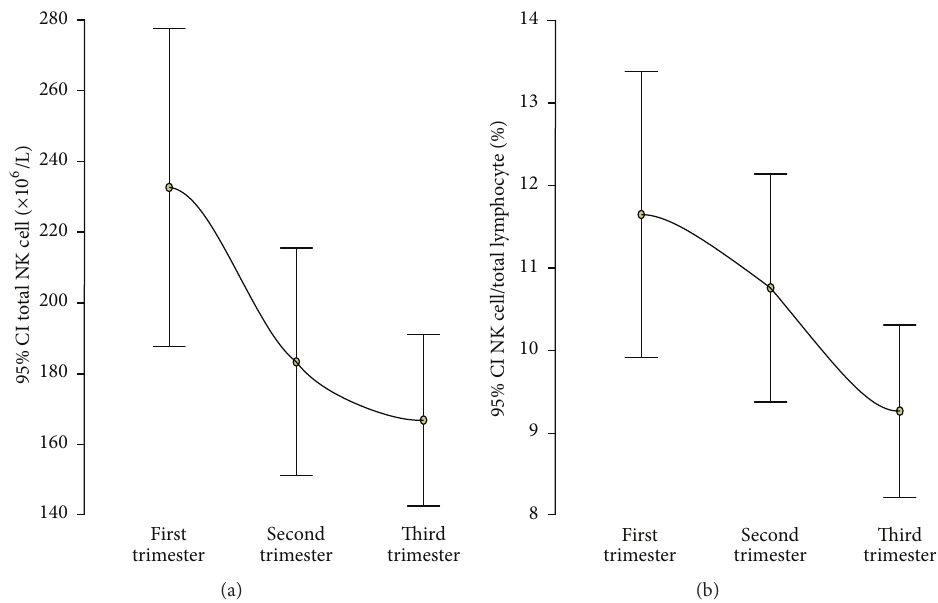
Figure 3: Error bar plots of the mean and 95% confidence interval of total natural killer (NK) cell count (a) and NK cell/total lymphocyte count (%) (b) in each trimester of pregnancy.